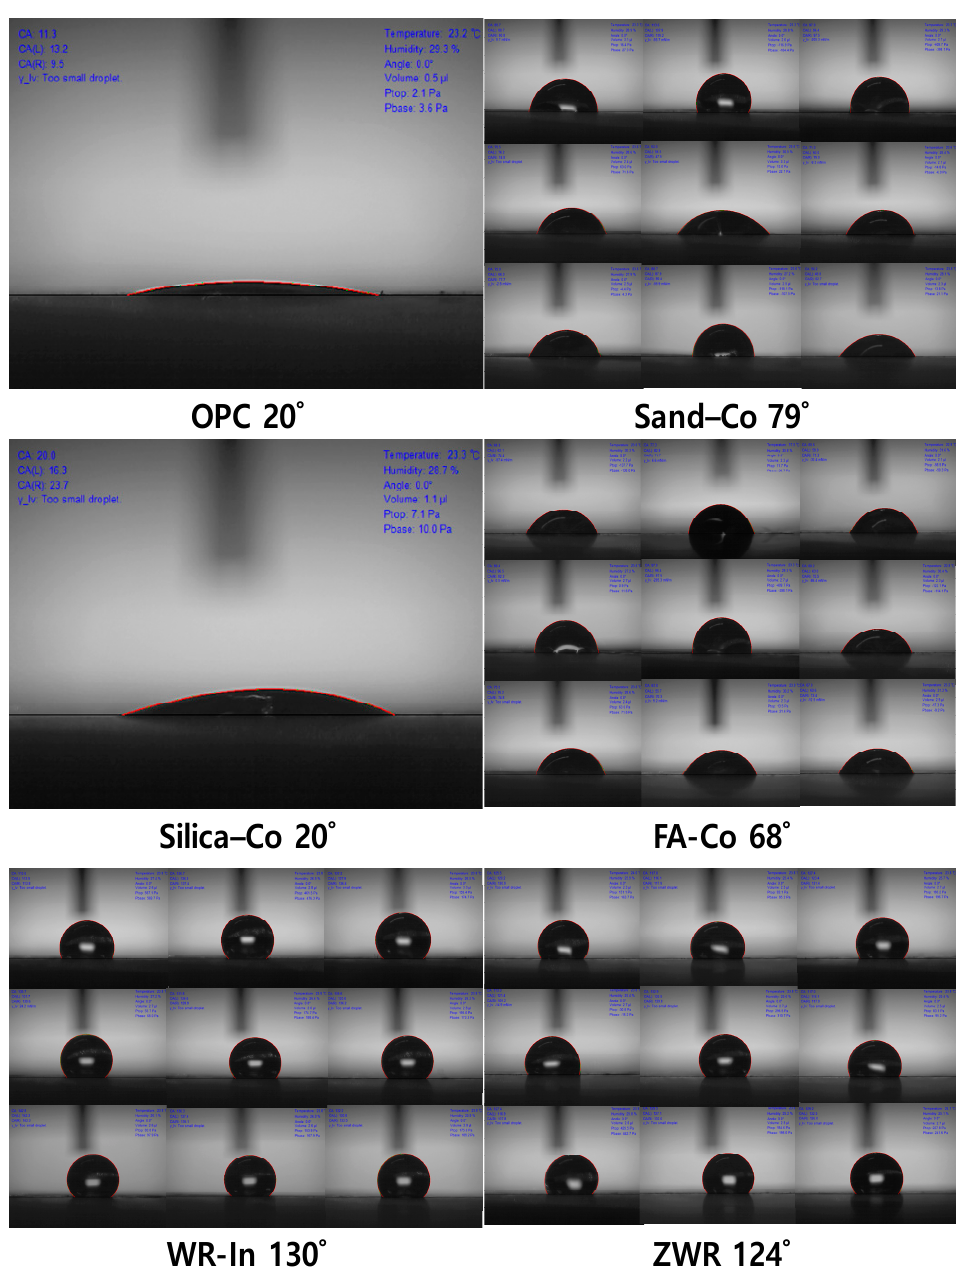
Figure 9. Result of the contact angle test.